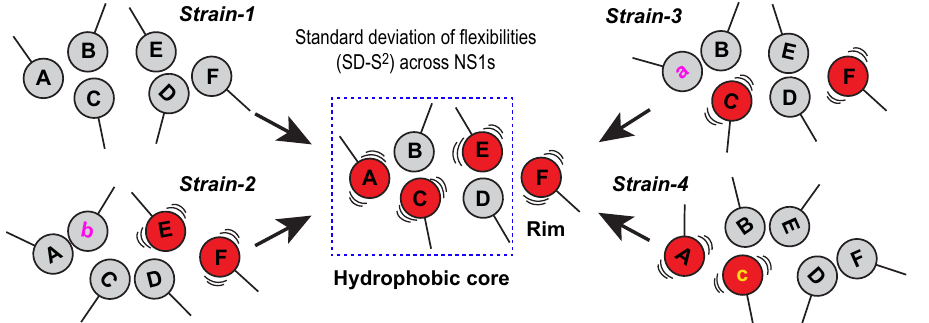
Fig. 6 | Statistical view of long-range epistasis. Interactions between residues A and F may not be detectable in individual NS1s, as strain-speci fi c mutations (denoted by a, b, and c) differently perturb the fl exibility of individual residues. However, residues with large changes in fl exibility (red balls) during evolution can be identi fi ed by comparing the standard deviation of fl exibility among NS1s. The